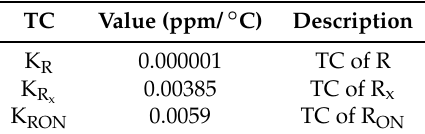
Table 1. Temperature Coefficients (TCs).